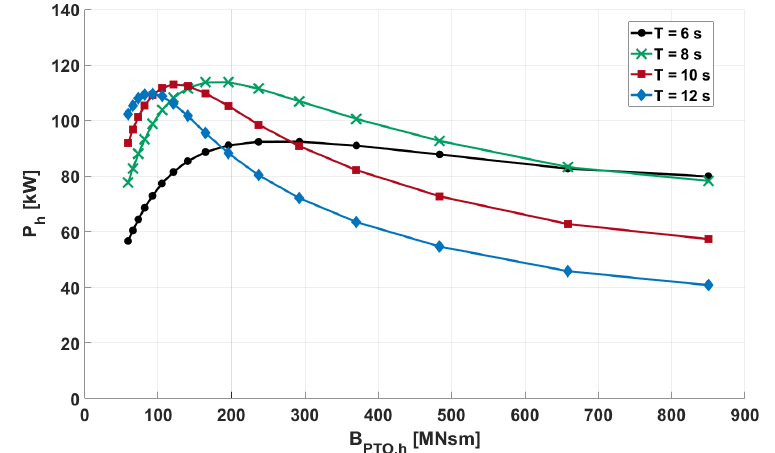
Figure 5. Average absorbed power P h as function of hydraulic damping coefficient B PTO , h for the OSWEC for four different wave periods and for a wave height H = 1.0 m.